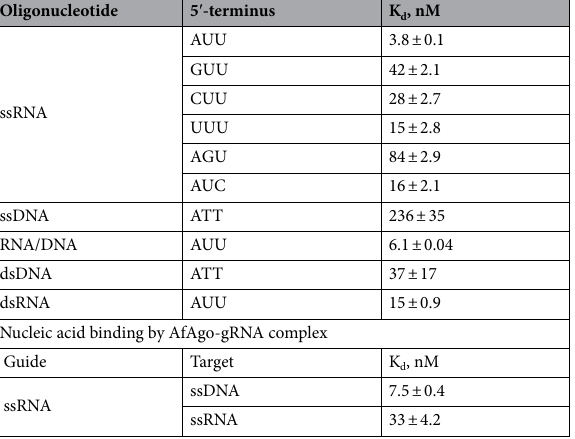
Table 1. Apparent K d of different tested nucleic acid substrates determined using EMSA. K d of a pre-formed AfAgo-guide complex with ssRNA and ssDNA target oligonucleotide were determined for one putative optimal ssRNA guide and two targets complementary to the guide within the “seed” region. K d was calculated from experimental results where heparin was omitted. Values are means ± standard deviation of three independent